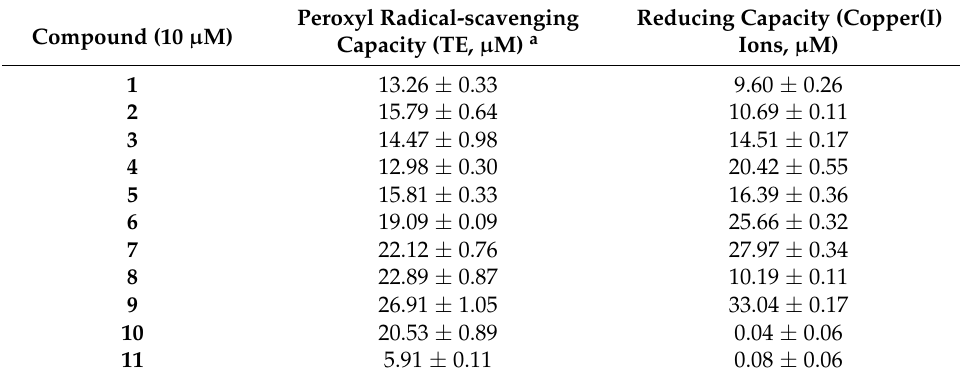
Table 2. The antioxidant activities of compounds isolated from the stems of Z. piperitum. Compound (10 μM)